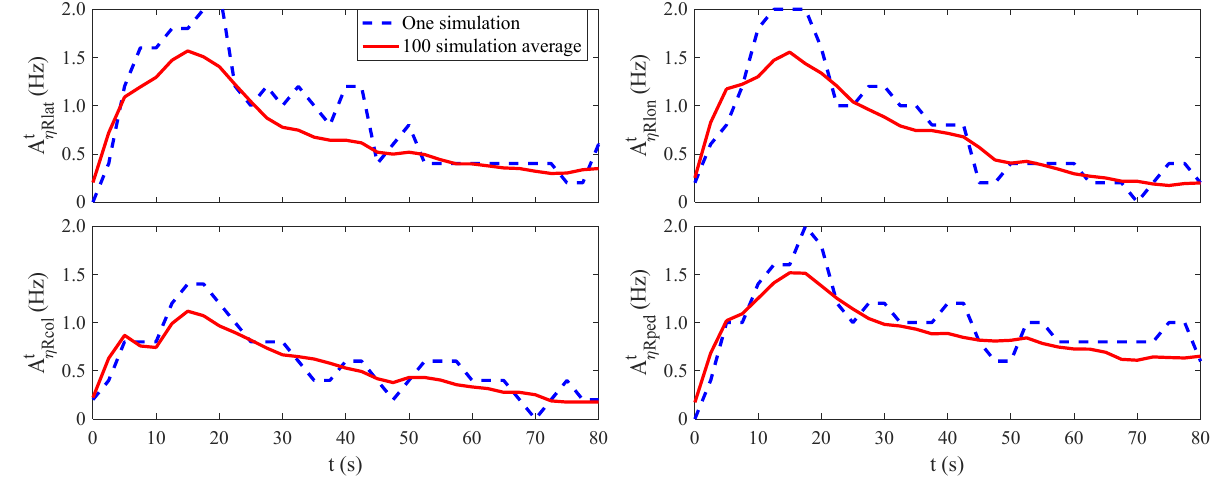
Figure 16. Time-varying attack activity rates in four control channels for Case 1 with SAS off.